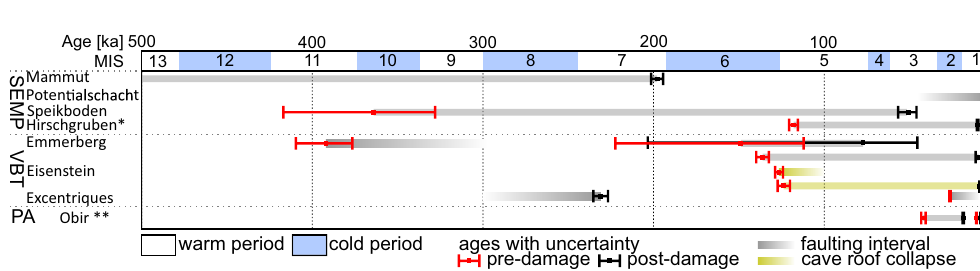
Figure 4. Age distribution of damaged speleothems in studied caves against the marine isotope stages (MIS); for caves location see Fig. 1; * 11 ; ** 17